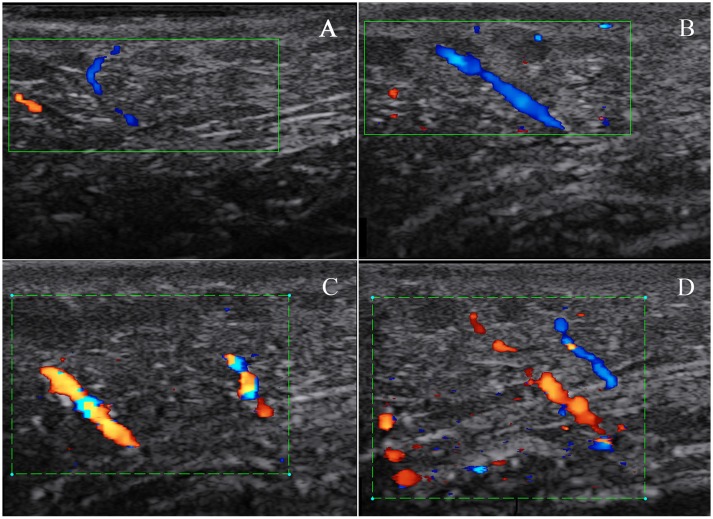
Subcutaneous blood flow in a swine DCS model. The swine was subjected to a simulated air dive to 40 m for 35 min with an 11 min decompression. Skin blood flow was detected by color Doppler scanning on normal skin in the lateral neck before the dive and repeated on a lesion in the same location. Only two small vessels in subcutaneous tissue were found in normal skin (A). More apparent blood flow signals in the same site were detected on a Stage III lesion, and images in (B–D) show the changes in blood flow signals at different probe angles during detection.